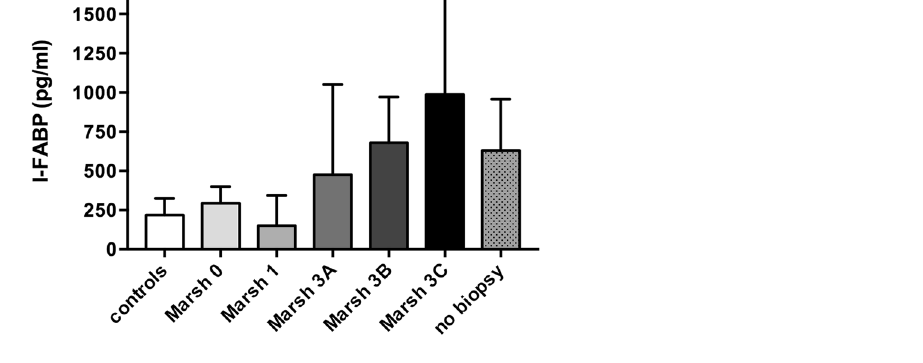
Figure 5. Plasma I-FABP levels stratified for the degree of villous atrophy at time of diagnosis of CD. * Significantly elevated compared with controls, # Significantly elevated compared with Marsh 0, and Marsh